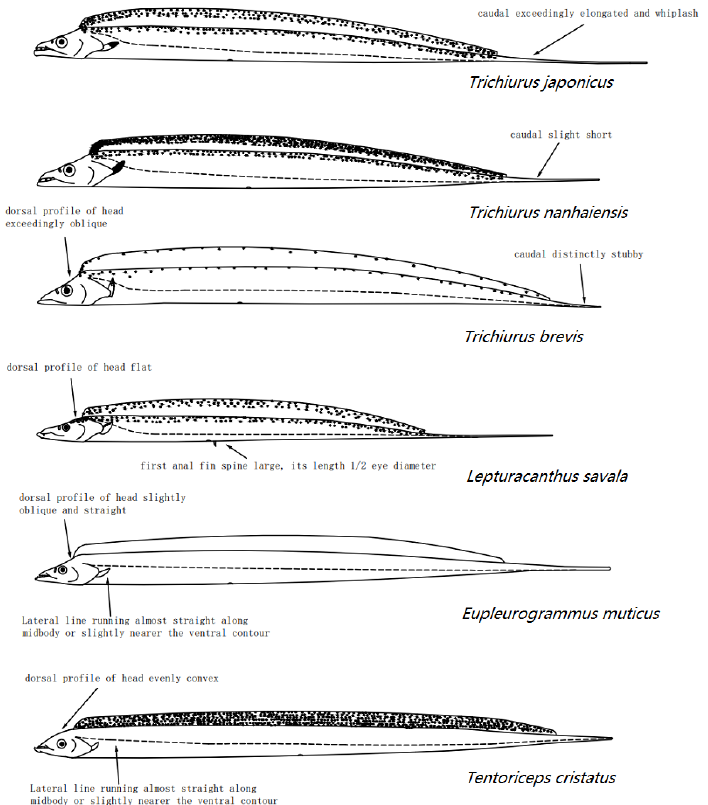
Figure A5. Hand drawing of six hairtails in the Chinese seas, with details of morphological charac- teristics for species identification.